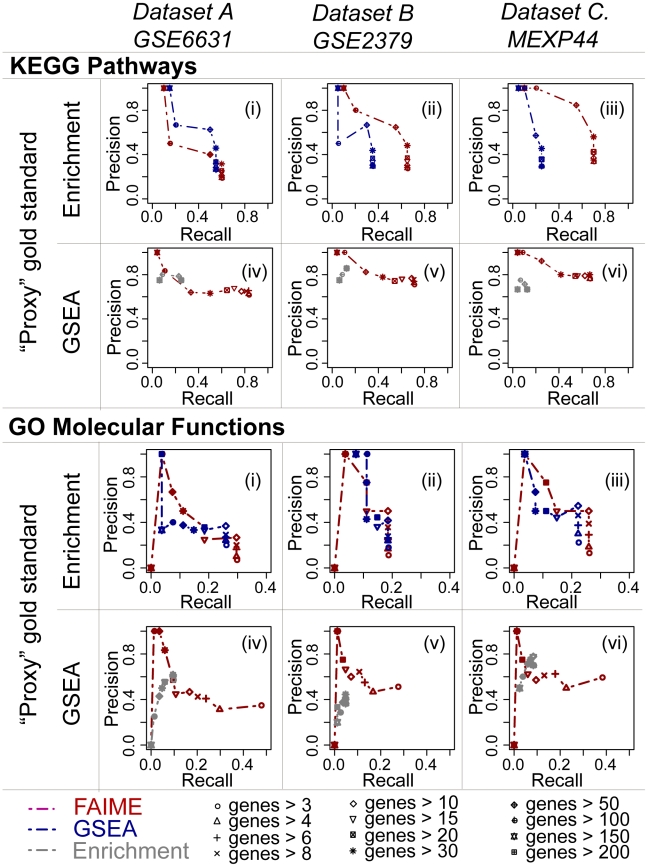
Molecular pathway and function concordance between conventional enrichment methods and differential expression of FAIME profiles.To establish that FAIME profiles yield relevant GO terms and KEGG pathways, we compared the differential expression of these profiles to conventional enrichment studies in three independent HNSCC studies (Figure 3, Table 1, Methods). Enrichment and GSEA studies have been extensively relied upon in biological and clinical studies and are thus alternatively used here as proxy gold standards and positive controls. FAIME-derived significantly altered KEGG and GO-MF (red) of each dataset are compared to those of GSEA (blue) using Enrichment results as a “proxy gold standard” (i,ii,iii in both the KEGG pathway and GO-MF panels). Similarly, these FAIME-derived significantly altered KEGG and GO-MF (red) are also compared to those of Enrichment (grey) using GSEA as the proxy gold standard (iv,v,vi in both panels). The results are reported according to the number of genes annotated in each KEGG pathway and GO term that are detectable on each respective type of array (Table 1). As shown above, FAIME's accuracy is comparable or better than those of the contrasted methods in 10 of the 12 precision-recall curves. Additionally, the high precision of deregulated FAIME profiles between HNSCC tumors and non-tumor control tissues is illustrated against that of a conservative empirical control distribution using pooled GSEA results as a “proxy gold standard” in Figure S3.